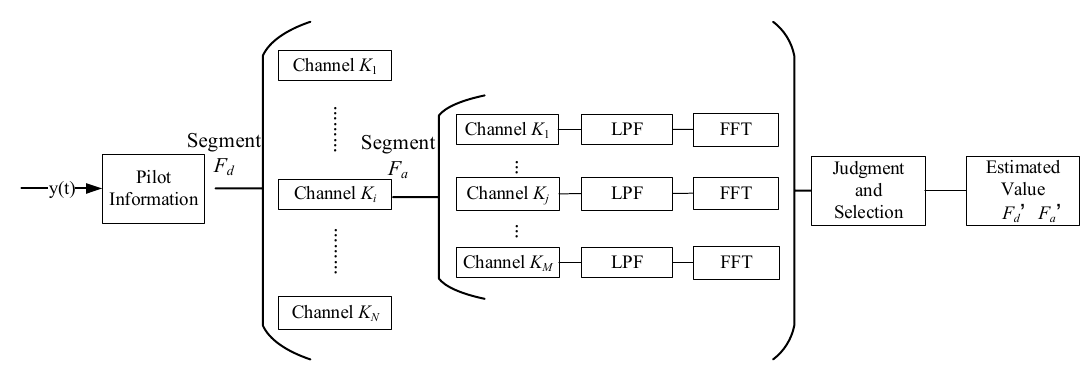
Figure 2. Parallel fast acquisition process based on multiple channels.